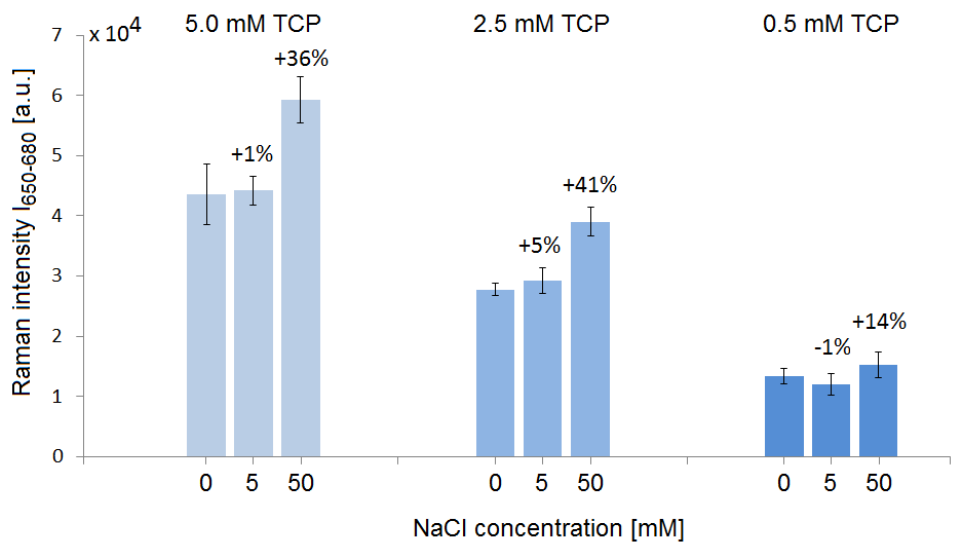
Figure 8. The effect of cross gradient of NaCl and TCP on SERS intensity with SK307 substrate. The horizontal axis represents the combinations of TCP and NaCl concentrations (in mM). Vertical axis shows the Raman intensity I 650–680 . The Raman intensity of the TCP signal increased significantly when 50 mM NaCl was present in the samples. Each data-point was averaged from 10 measurements. Error bars: 95% confidence interval.